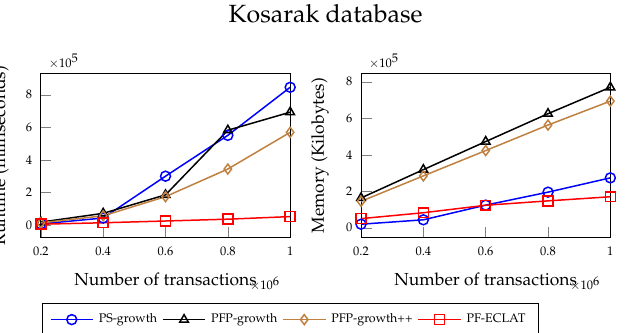
Figure 10. Scalability of PFP-growth, PFP-growth++, PS-growth, and PF-ECLAT.